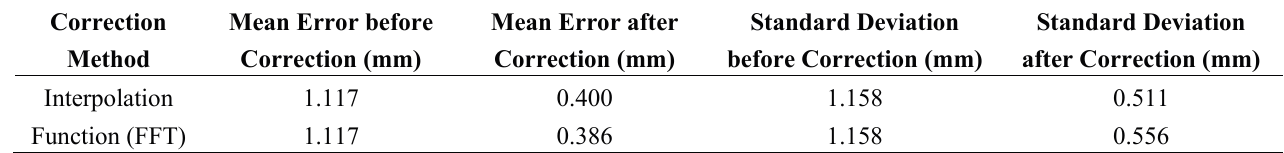
Table 14. Effectiveness of the corrections application–Trimble S6, 67 distances.